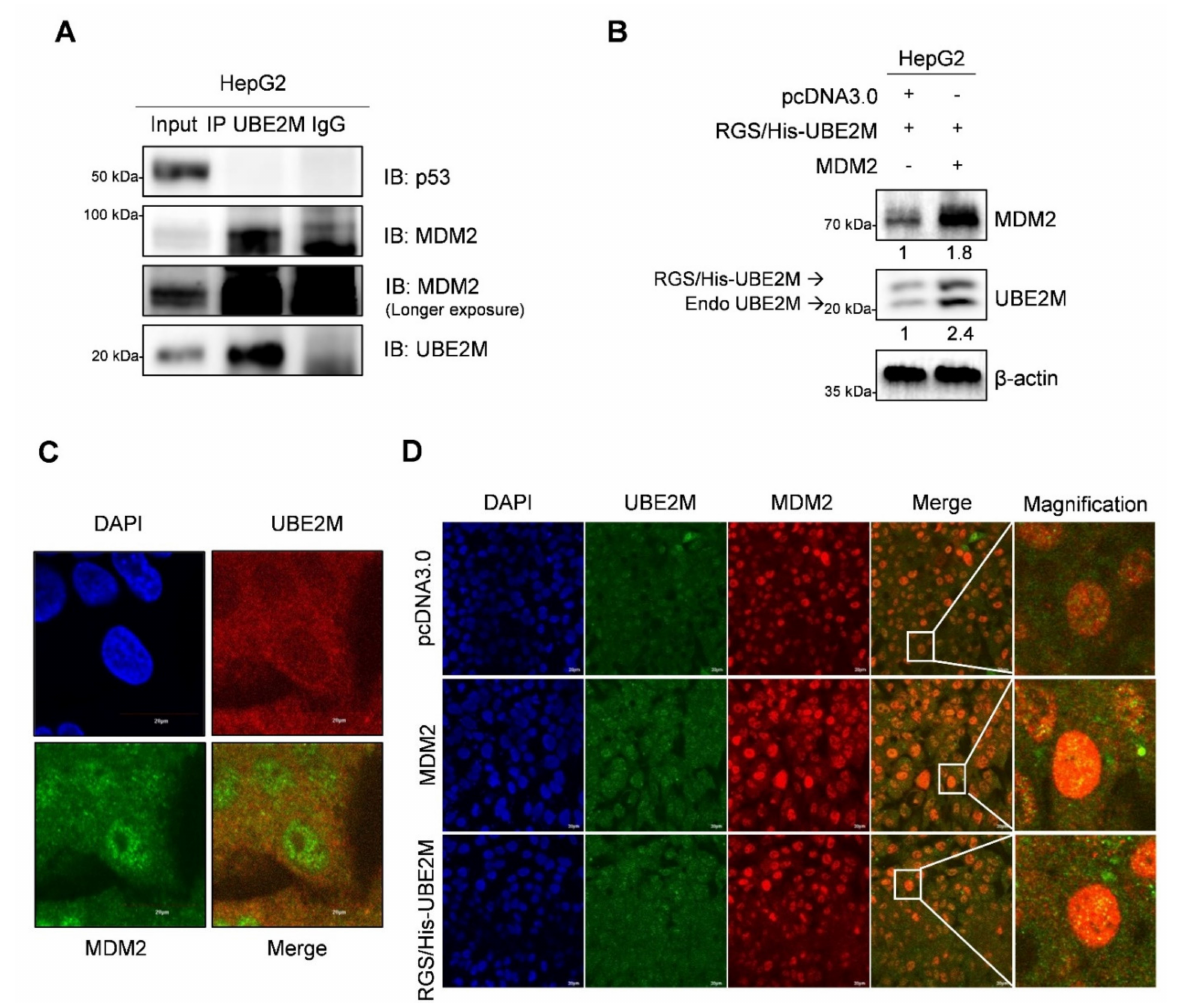
Figure 5. UBE2M binds to MDM2, but regulates p53 via their crosstalk in HepG2 cells. ( A ) UBE2M binds to MDM2, but not to p53, in HepG2 cells. Immunoprecipitation was conducted in HepG2 cells to identify the endogenous interaction between UBE2M and p53, or MDM2 in the presence of MG132. ( B ) UBE2M activates MDM2 in HepG2 cells. HepG2 cells transfected with pcDNA3.0, RGS/His-UBE2M and MDM2 plasmids were lysed and immunoblotted with anti-MDM2, UBE2M and β -actin antibody. ( C ) The colocalization between MDM2 and UBE2M in HepG2 cells at endogenous level by immunofluorescence with ALEXA 488, 596 and DAPI staining. ( D ) The colocalization between MDM2 and UBE2M at exogenous level in HepG2 cells transfected with pcDNA3.0, RGS/His-UBE2M and MDM2 plasmids by immunofluorescence with ALEXA488, 596 and DAPI staining. ×